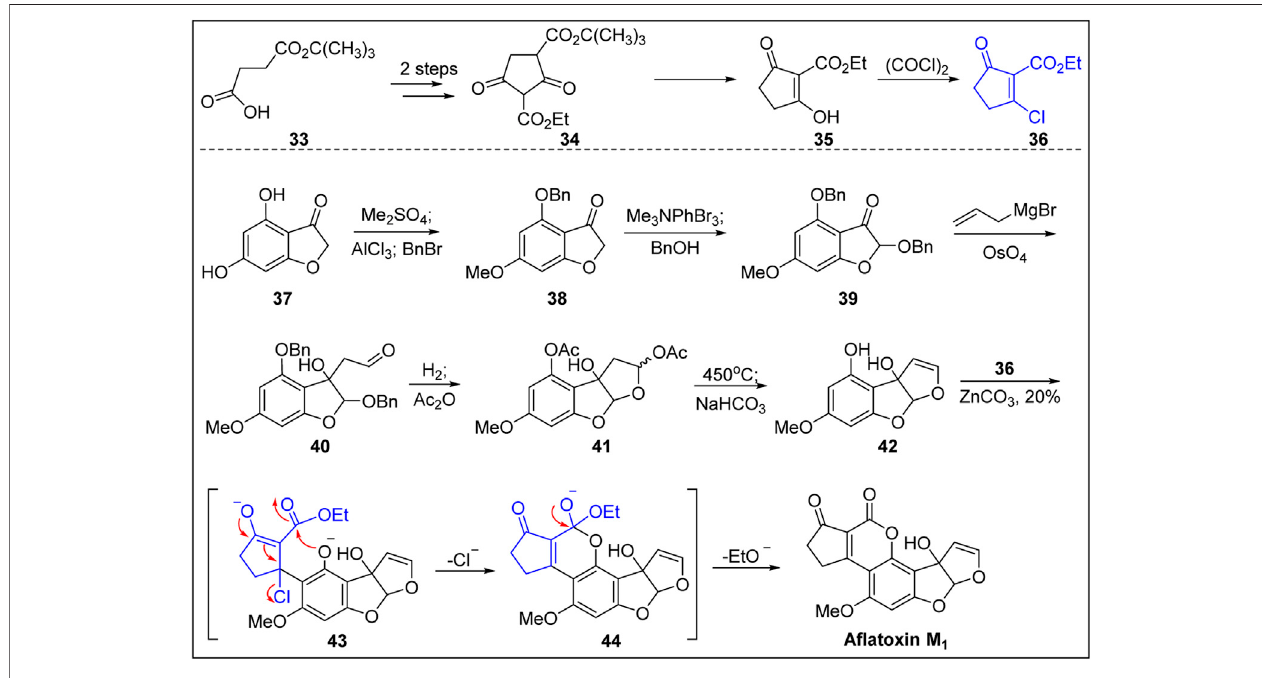
FIGURE 4 | First total synthesis of ( ± )-a fl atoxin M